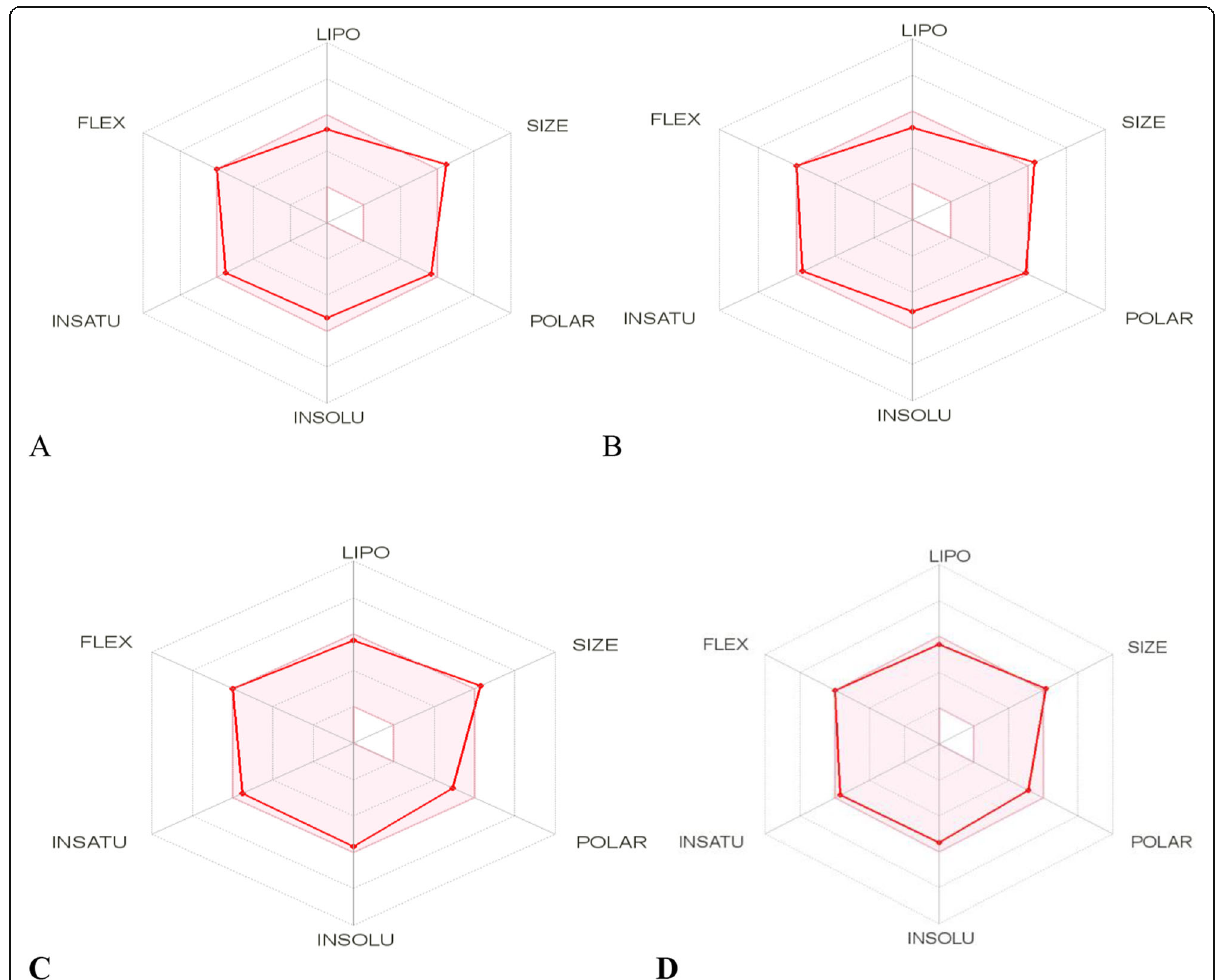
Fig. 5 The bioavailability radar of ( a ) Molecule 22, ( b ) Molecule 24, ( c ) Molecule 17, and ( d ) Molecule 19 generated from SWISS